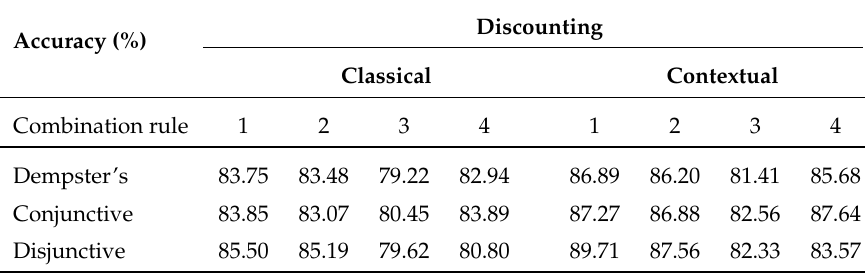
Table 2. Influence of the discounting techniques and the combination rules on the overall accuracy (%). Discounting Accuracy (%) Classical Contextual Combination rule